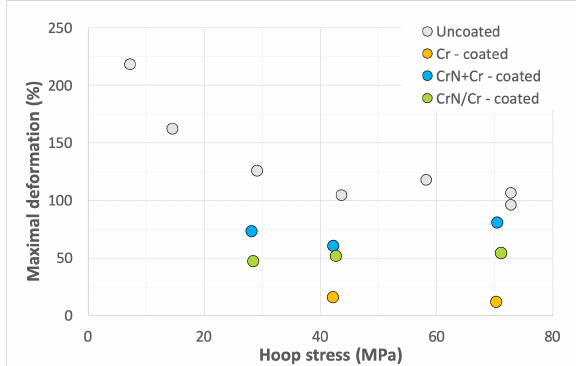
Figure 5. Maximal deformation at temperature 800 ◦ C in relation to hoop stress for different types of coatings and uncoated